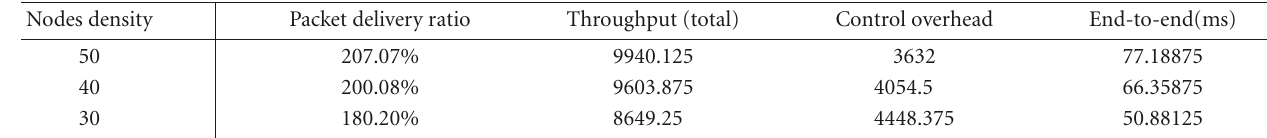
Table 5: Total value for di ff erent nodes